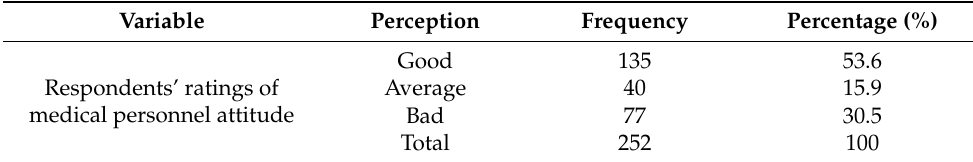
Table 3. Distribution of respondents’ perceptions of medical personnel